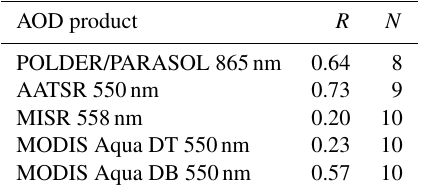
Table 3. Spatial correlation between PM 2 . 5 mass density and AOD using medians of coincident data at 10 sites in the AOSR. Wapasu has insufficient or no temporal overlap with POLDER/PARASOL and AATSR. Syncrude UE1 is not spatially coincident with any of the POLDER locations given the 10km criterion (see Sect.